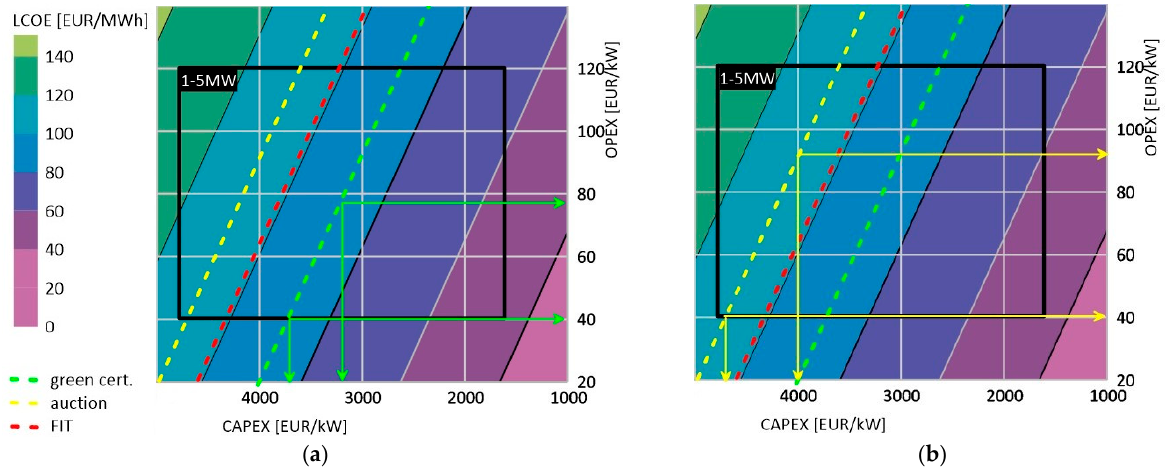
Figure 6. Examples of CAPEX and OPEX boundaries for SHP ensuring the achievement of LCOE at the level of revenues that can be obtained ( a ) in the green certificates system ( b ) in the auction system. Source: own elaboration.